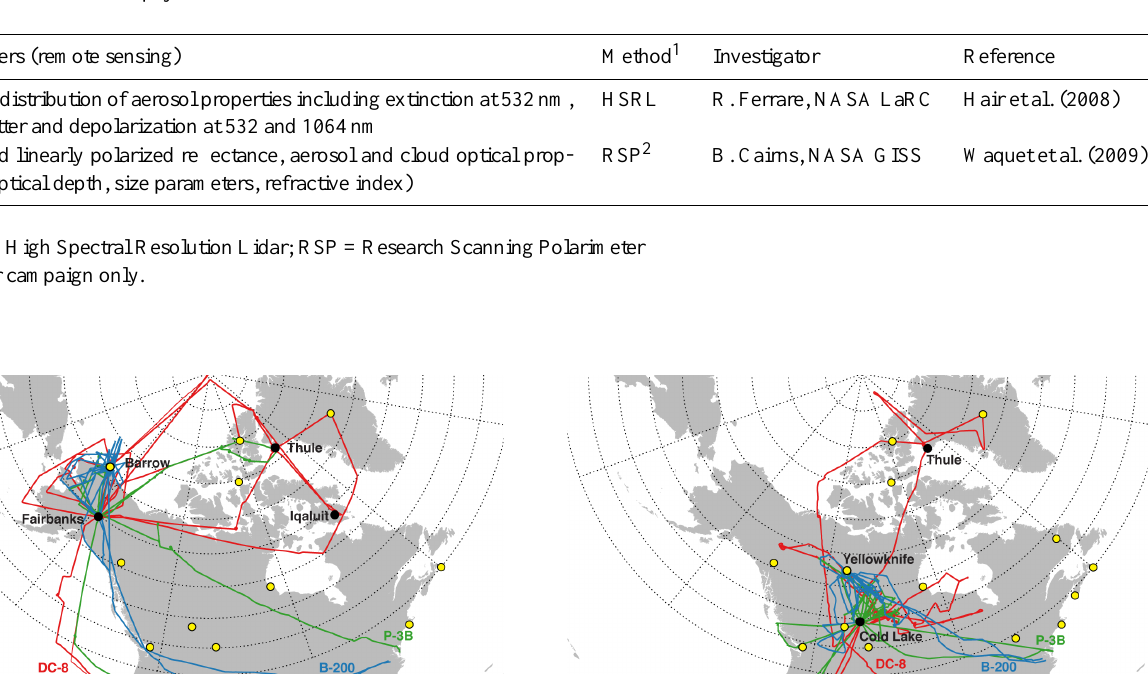
Table 3c. B-200 research payload in ARCTAS.